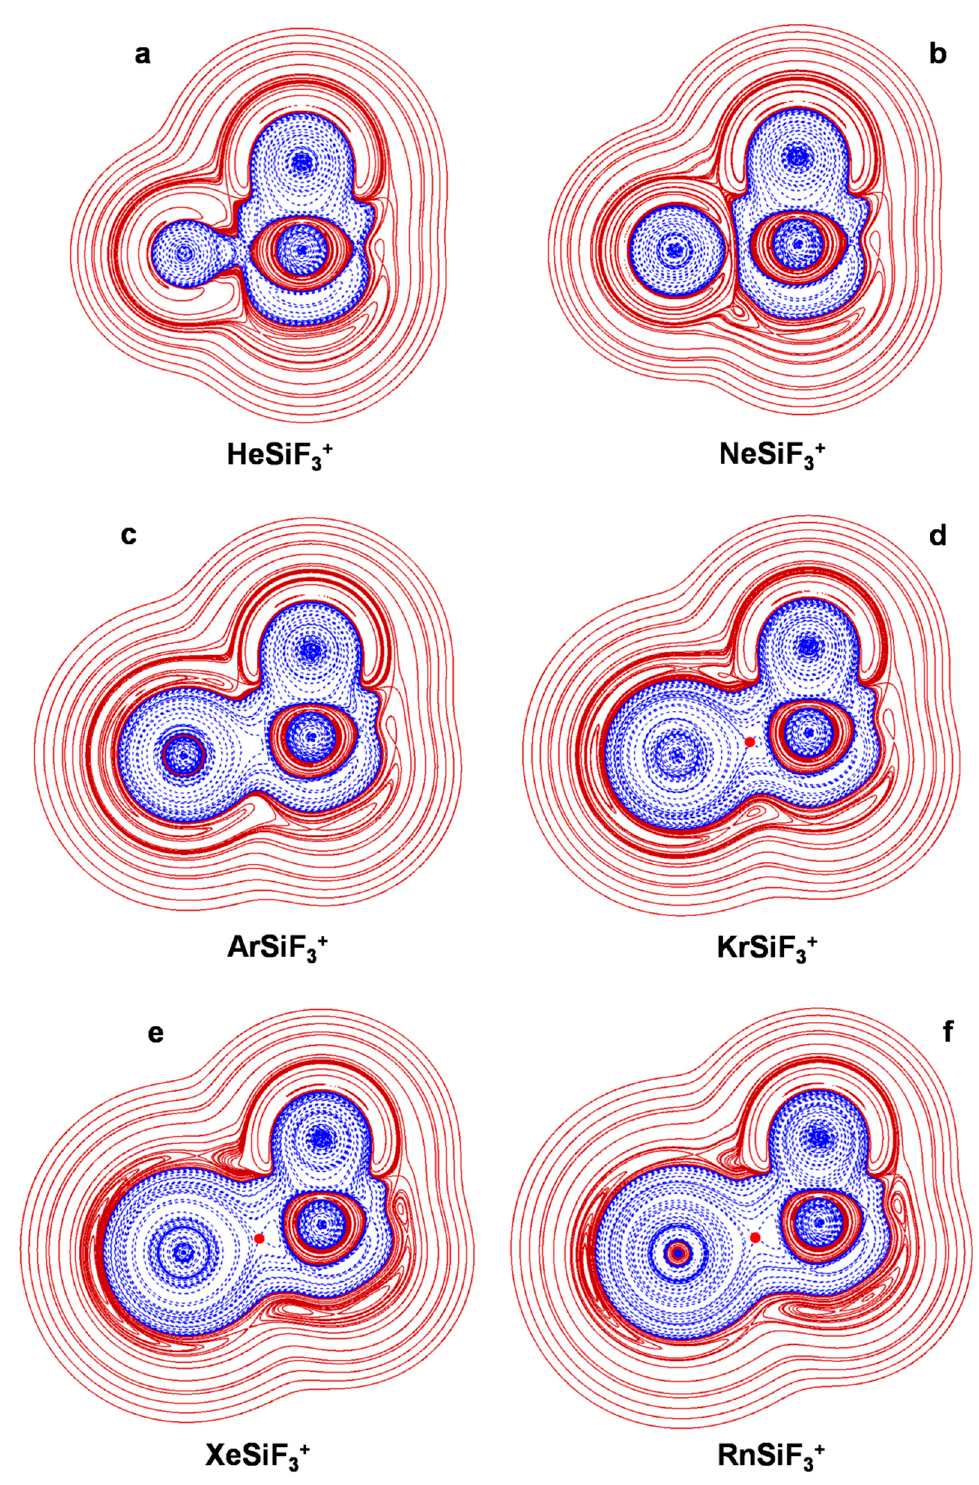
Figure 3. 2D plots of H ( r ) in the symmetry plane of ( a ) HeSiF 3+ ; ( b ) NeSiF 3+ ; ( c ) ArSiF 3+ ; ( d ) KrSiF 3+ ; ( e ) XeSiF 3+ ; ( f ) RnSiF 3+ (solid/brown and dashed/blue lines correspond, respectively, to positive and negative values). The red dots represent the HCPs.